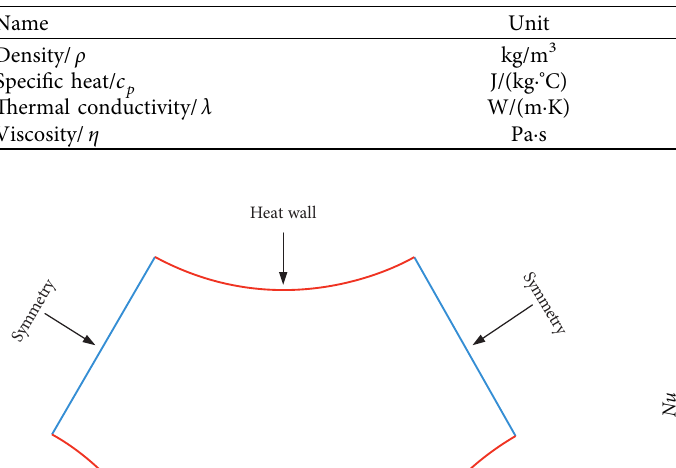
Table 2: The physical parameters of LBE.